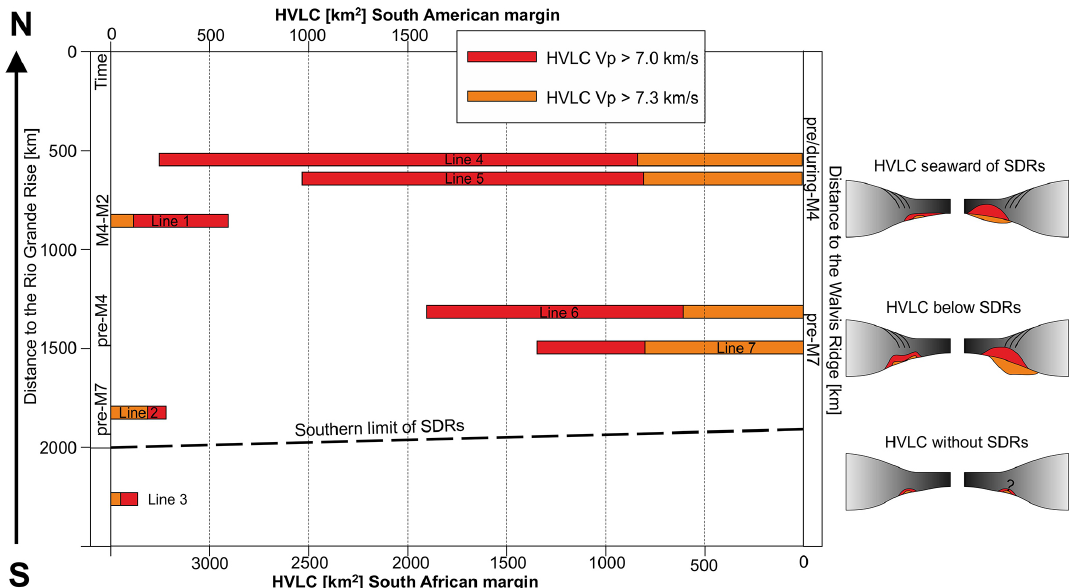
Figure 9. Comparative N–S volumes of HVLC in the South Atlantic along the crustal transects. HVLC on the South American margin is shown to the left and aligned according to the distance from the Rio Grande Rise (top). HVLC on the South African margins is shown to the right and aligned according to the distance from the Walvis Ridge (top). The timing of the emplacement of HVLC is indicated with respect to magnetic chrons M7, M4, and M2. Southern limit of the SDRs corresponds to the Colorado–Cape transfer zone as indicated in Fig. 1. The diagrams to the right show the respective spatial relation of the HVLC to the SDRs at the relative margin